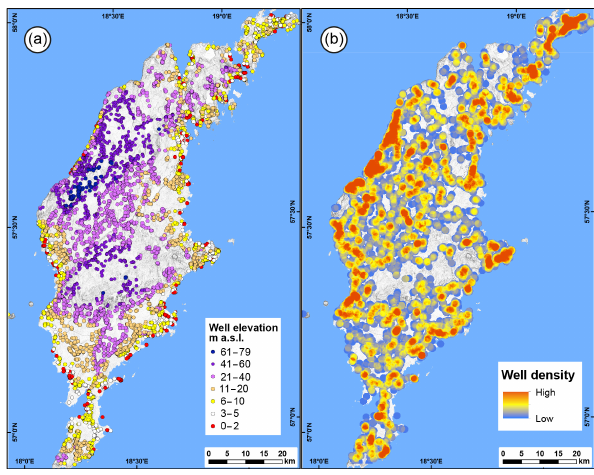
Figure 3. (a) Out of a total of 7354 wells, 231 are located on ele- vations 0–2m, corresponding to about 3% of all wells. These wells will be directly affected by sea level rise through inundation; how- ever, other wells on higher elevations further inland will be indi- rectly affected by salinization. (b) Well density expressed as point